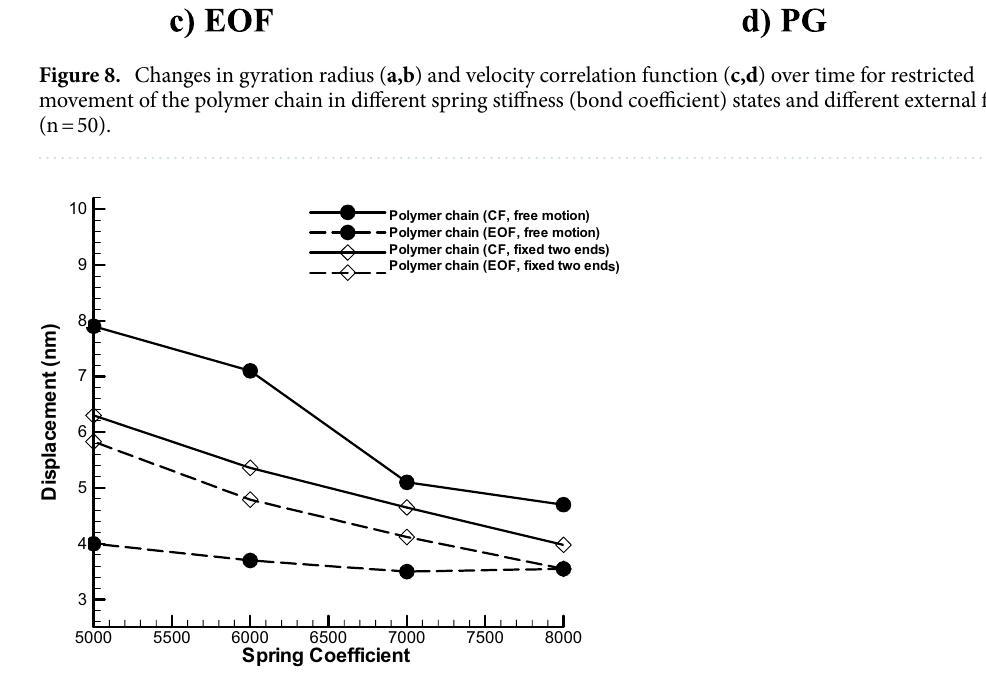
Figure 9. Polymer chain displacement to spring stiffness coefficient between beads for two modes of free and restricted movement for pressure gradient and electroosmotic test cases (n =